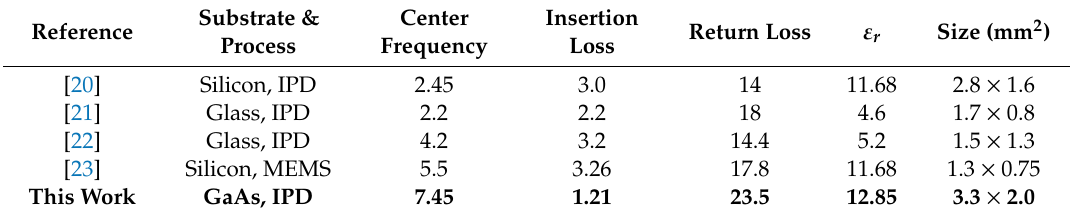
Table 1. Comparisons to other similar fabricated